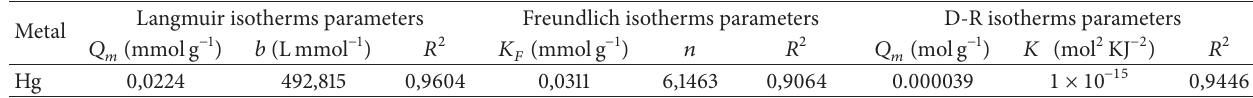
Table 8: Langmuir, Freundlich, and D-R isotherm constants of Hg.